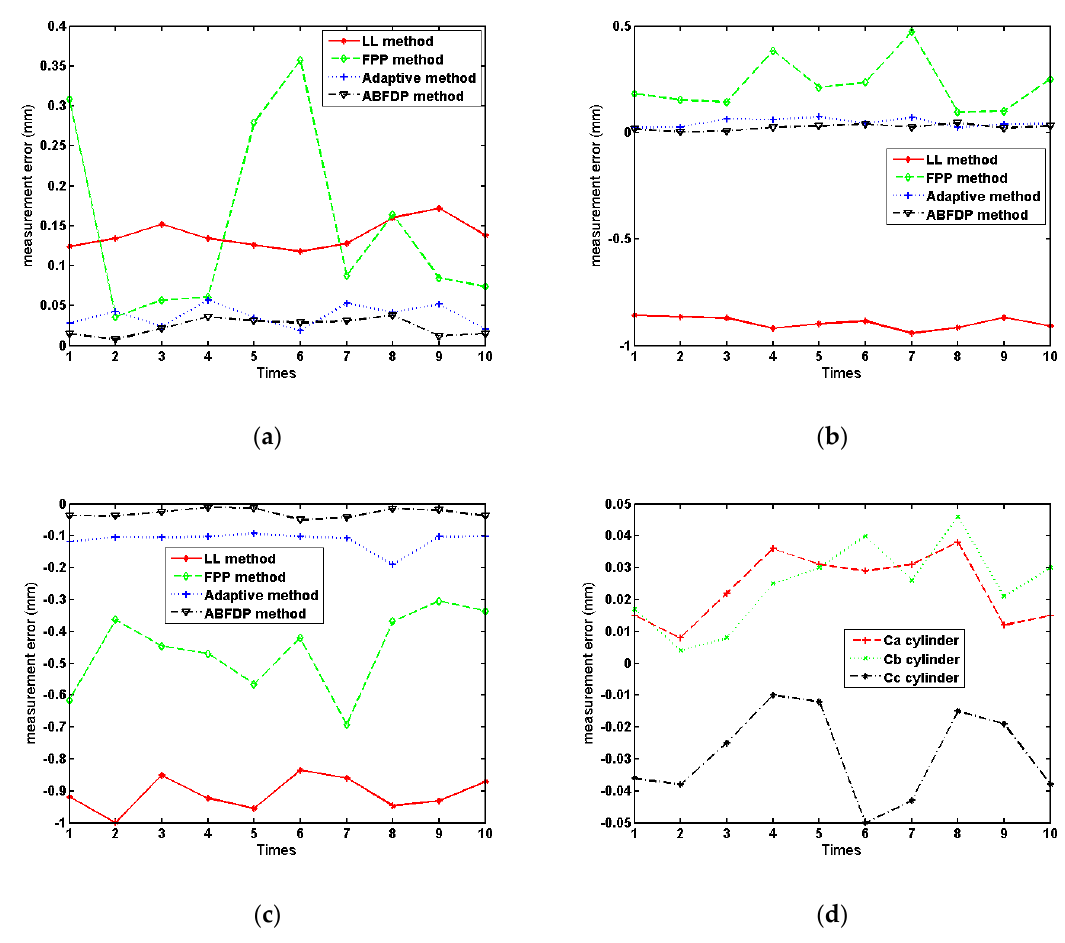
Figure 10. Measurement error distribution: ( a ) measurement error for cylinder C a ; ( b ) measurement error for cylinder C b ; ( c ) measurement error for cylinder C c ; ( d ) measurement error using ABFDP method.